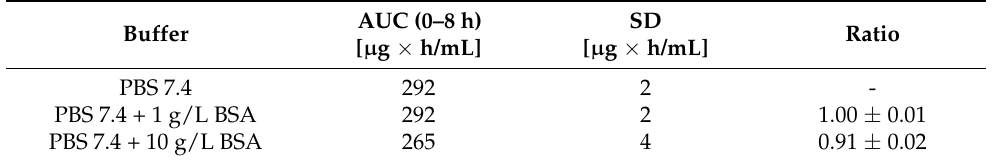
Table 3. Calculated AUC of diclofenac sodium permeation in PBS 7.4 with different BSA amounts ( n = 6).